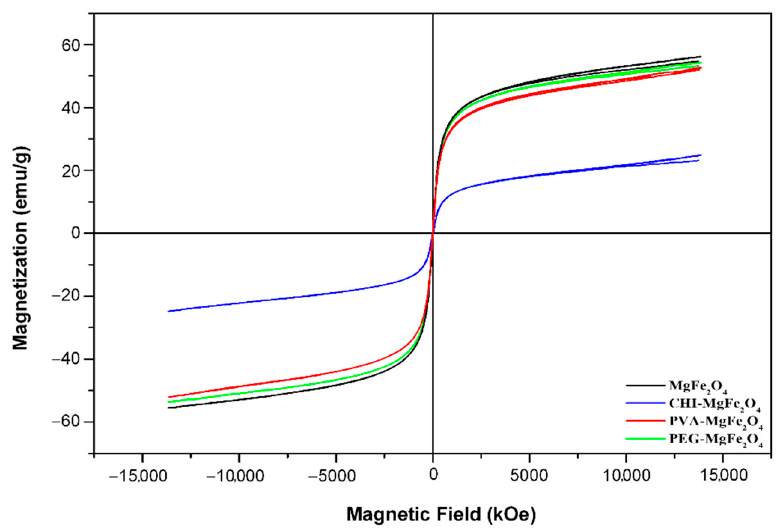
Figure 3. VSM magnetization profile of the MgFe 2 O 4 , CHI-MgFe 2 O 4 , PVA-MgFe 2 O 4 , and PEG- MgFe 2 O 4 MNPs. Table 2. Magnetization measurements obtained for the MNPs.